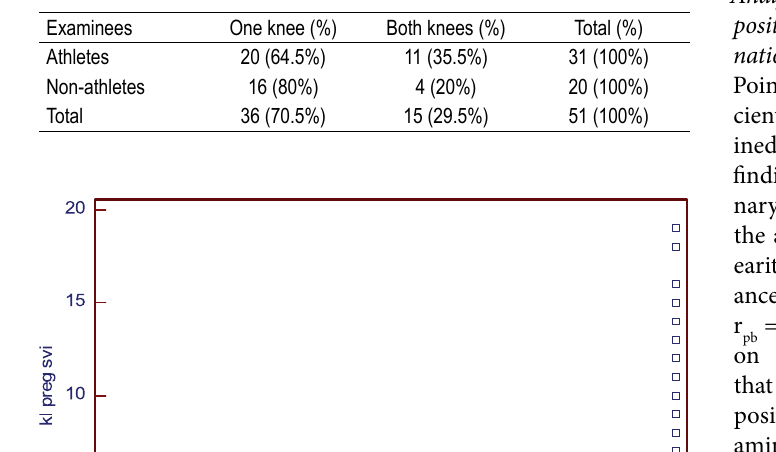
Table 4. oSd disease prevalence estimation in one or both knees